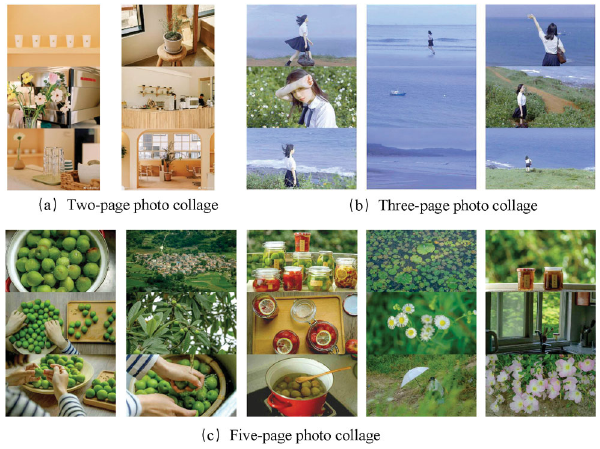
Fig. 1 Multi-page photo collage examples on social